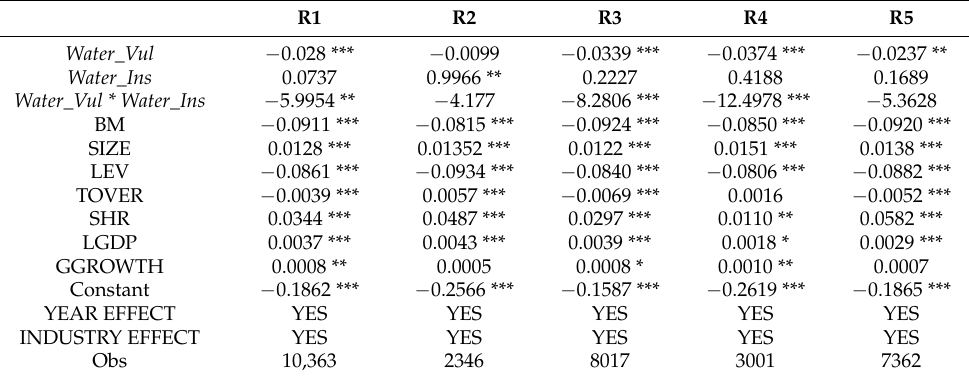
Table 7. The moderating effect of water regulation on corporate financial